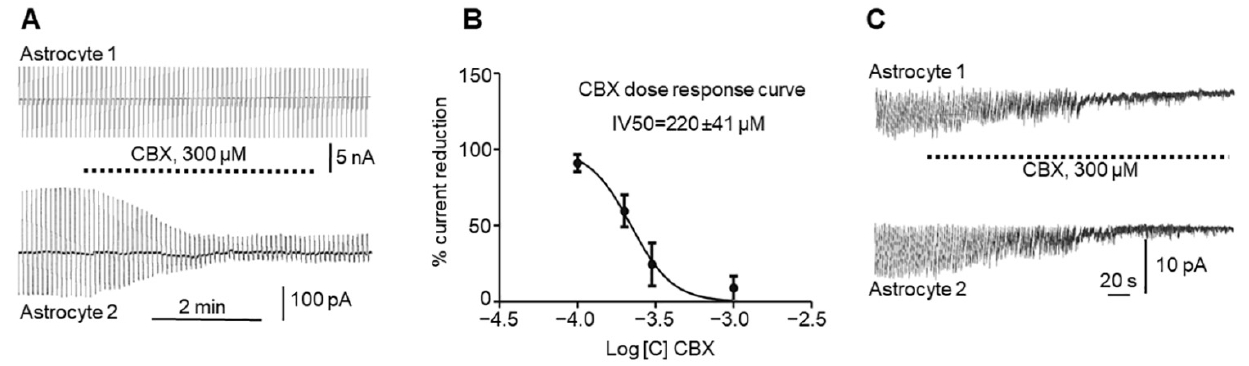
Figure 2. Effects of CBX on astrocyte gap junctions and on astrocyte activity elicited by 4-AP: ( A ). Reduction in gap junction current between astrocytes (lower curve) by application of 300 µM CBX to the bath (see text). ( B ). Dose–response curve of the CBX effect on inter-astrocyte gap junctions, with error bars representing SD. ( C ). CBX at a 300 µM concentration simultaneously reduces astrocytic “epileptiform” activity elicited by 4-AP in two astrocytes in the hippocampal slice.